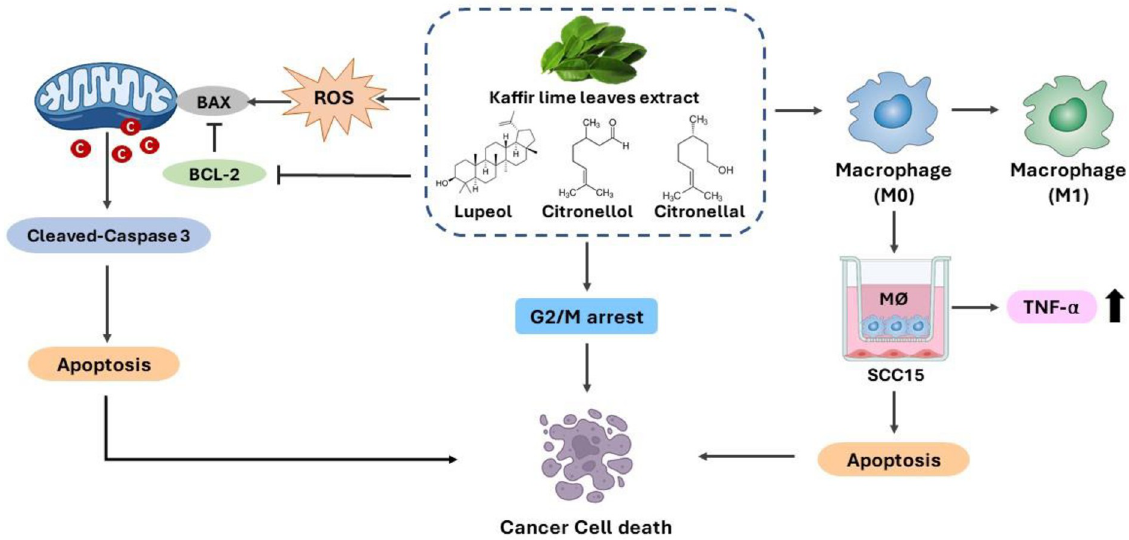
Fig 10. Anti-proliferative and immunomodulatory activity of kaffir lime leaf (KL) extracts and their bioactive compounds. KL extracts and the contained compounds induced G2/M cell cycle arrest. Apoptosis was stimulated by the treatments with the extracts and active compounds through ROS production, increasing BAX and cleaved-caspase 3 expression and decreasing the level of Bcl-2. The plant extracts and contained compounds also polarized macrophage into M1 type and increased the secretion of TNF- α , leading to apoptosis of SCC15 in co-culture with